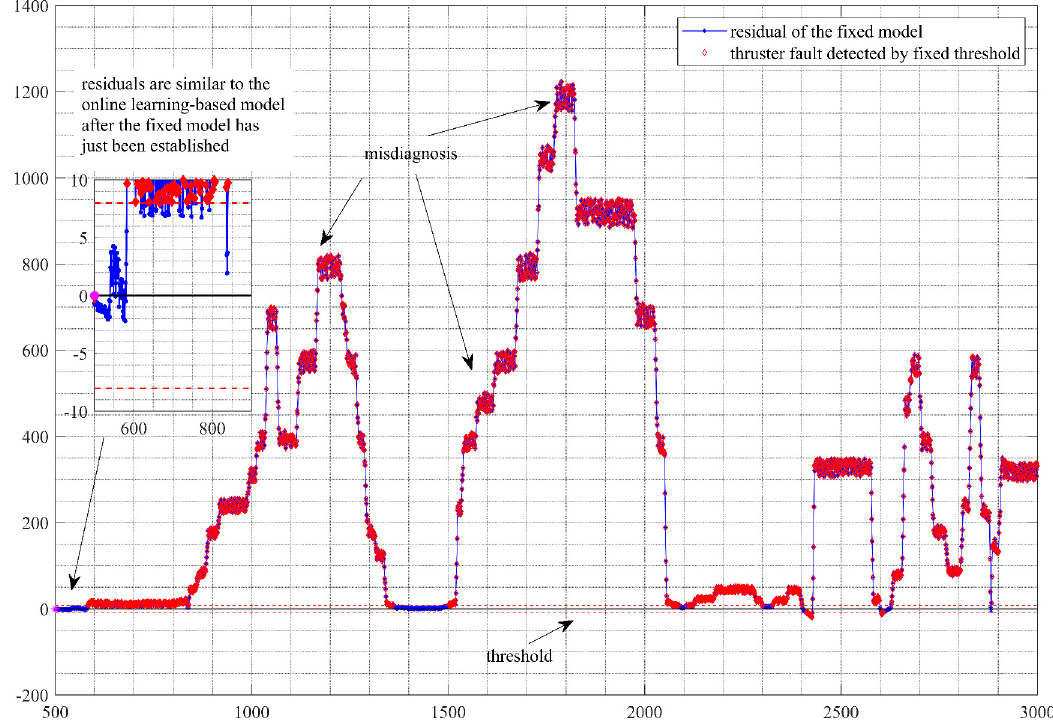
Figure 19. Model residuals of the online learning-based fault detection method during sea trial of the portable AUV.